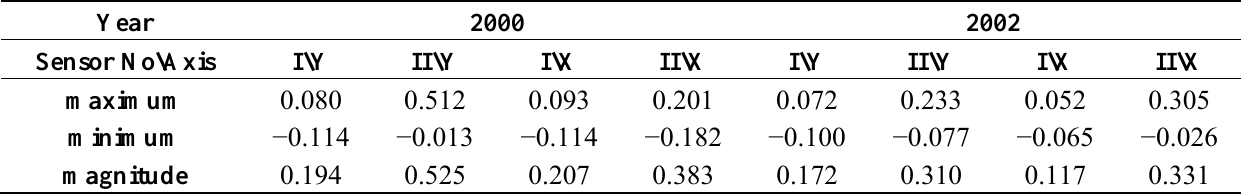
Table 4. Statistics of 2000 and 2002 campaigns: inclinations in mrad, ISTA geodetic pillar